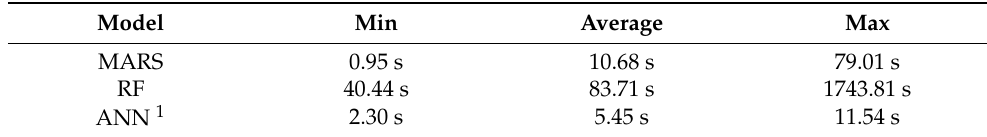
Table 3. Training Time Analysis (in seconds).